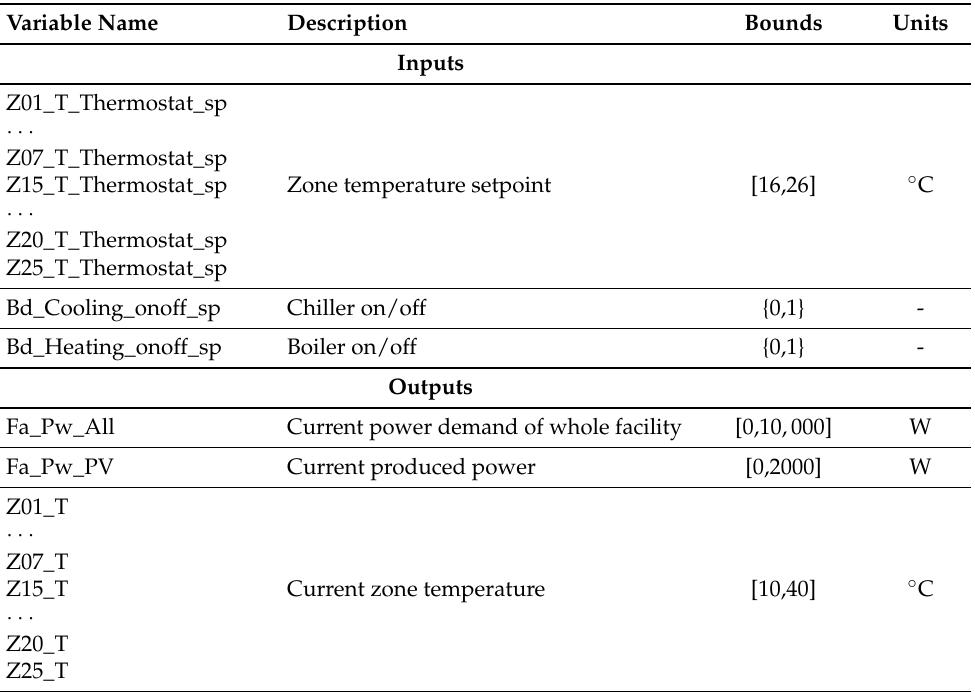
Table A3. Inputs and outputs for the model OfficesThermostat-v0.